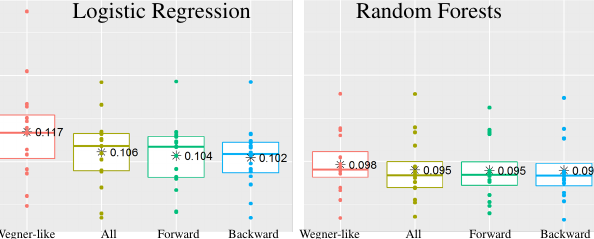
Figure 2: Resulting (superpixel-wise) average class error of the models trained on the feature sets produced by each variable se- lection method for each learning algorithm. Colored points de- note the performance (percentages of falsely classified superpix- els) of the relevant algorithm for the 16 patches. The colored lines and stars stand for average and median values, respectively.